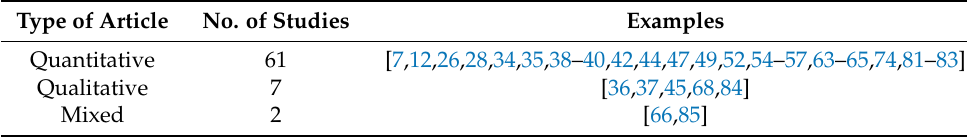
Table 3. Methodologies adopted in consumer engagement research.